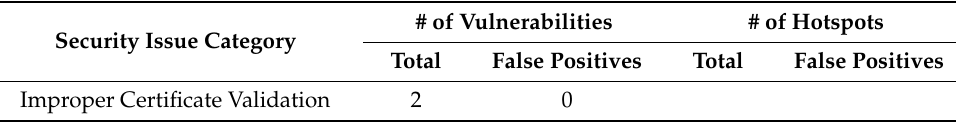
Table 8. Number of security issues of different categories in jSML.